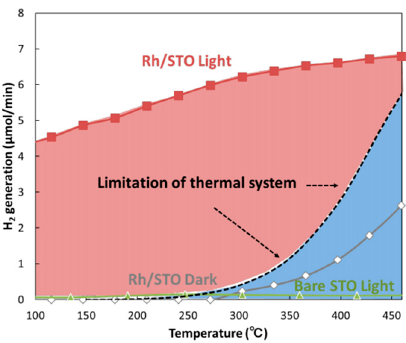
Figure 21. Photocatalytic activity of UV light-irradiated Rh/SrTiO 3 . The reaction was DRM. Reprinted from [30]. STO: SrTiO 3 .